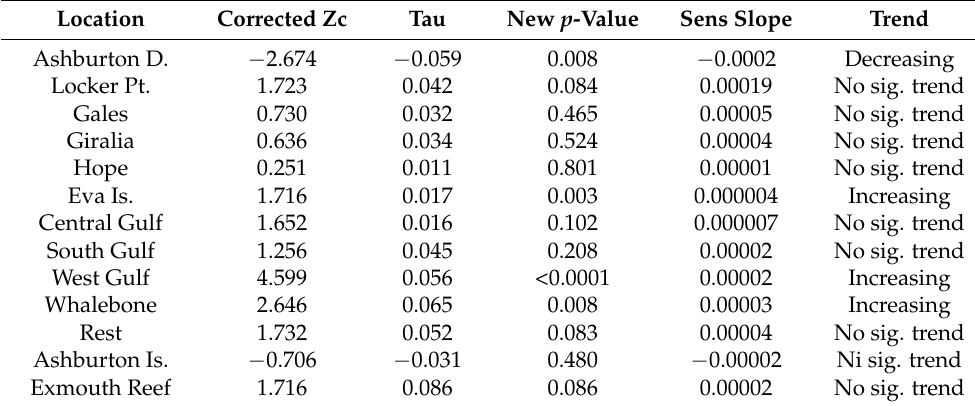
Table A1. Modified Mann–Kendall table of